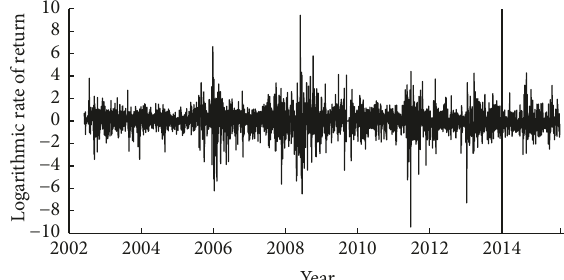
Figure 1: Modeling flow chart.